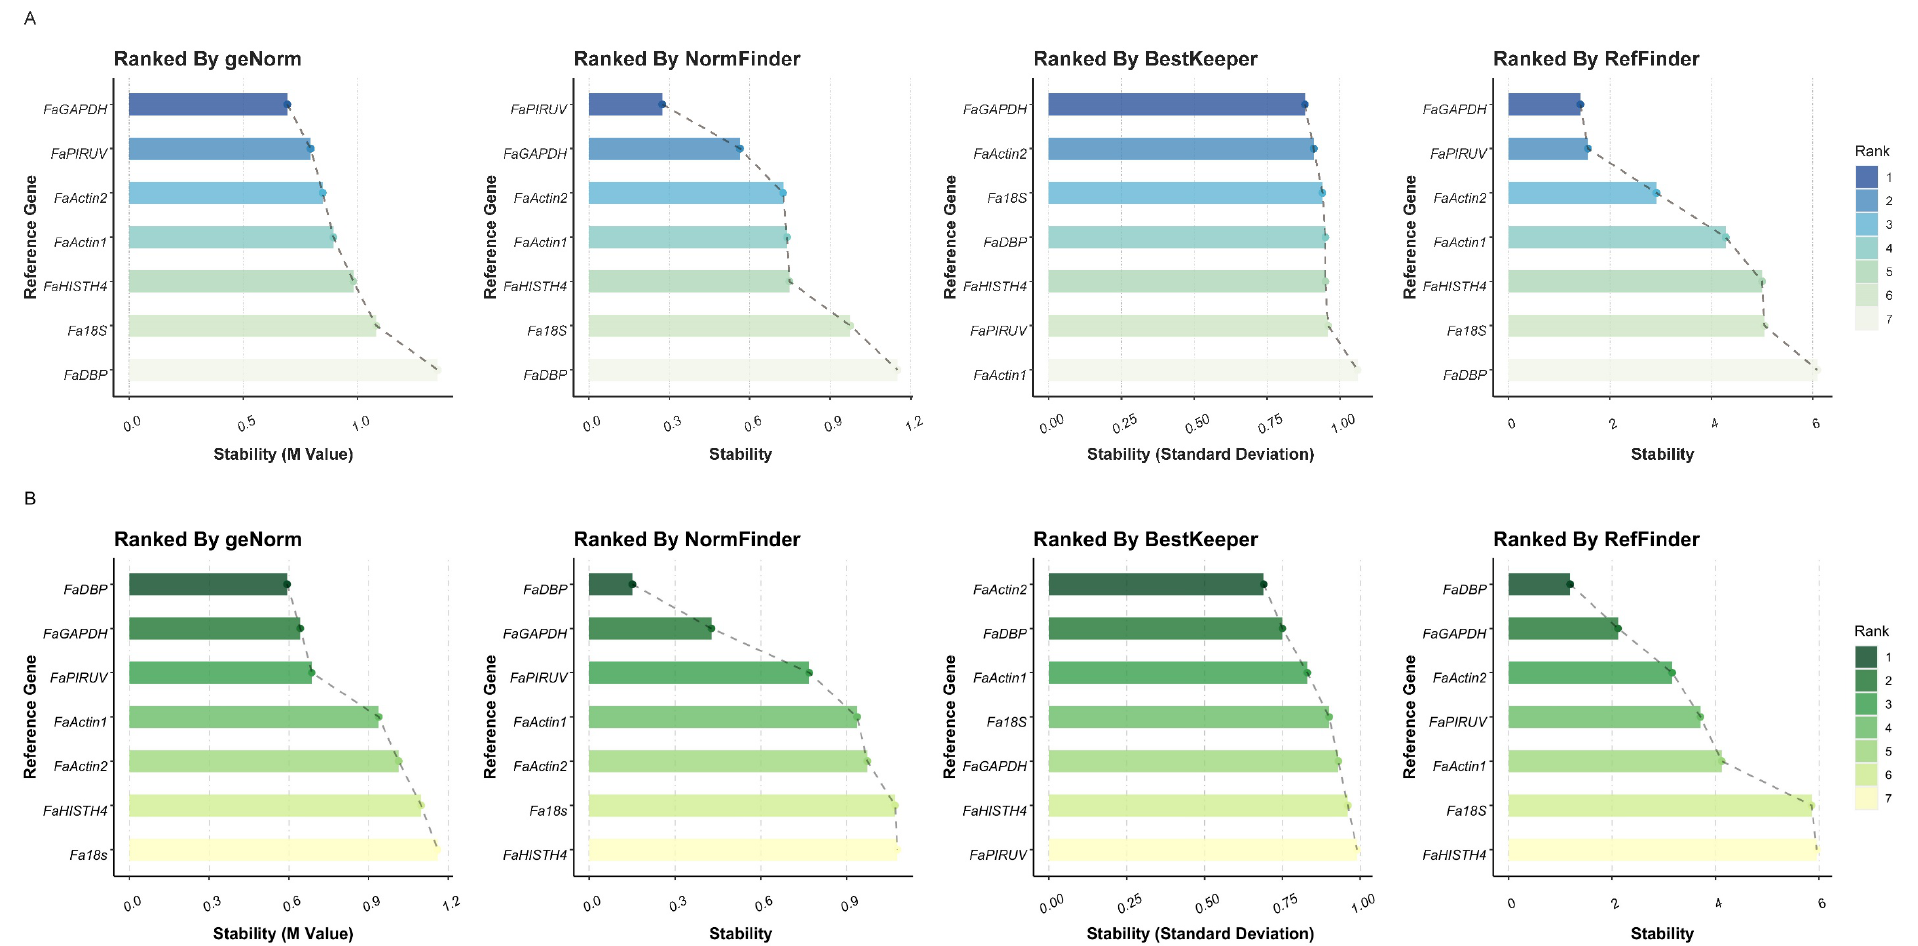
Figure 3. Expression stability ranks of the candidate reference genes under salt stress ( A ) and drought stress ( B